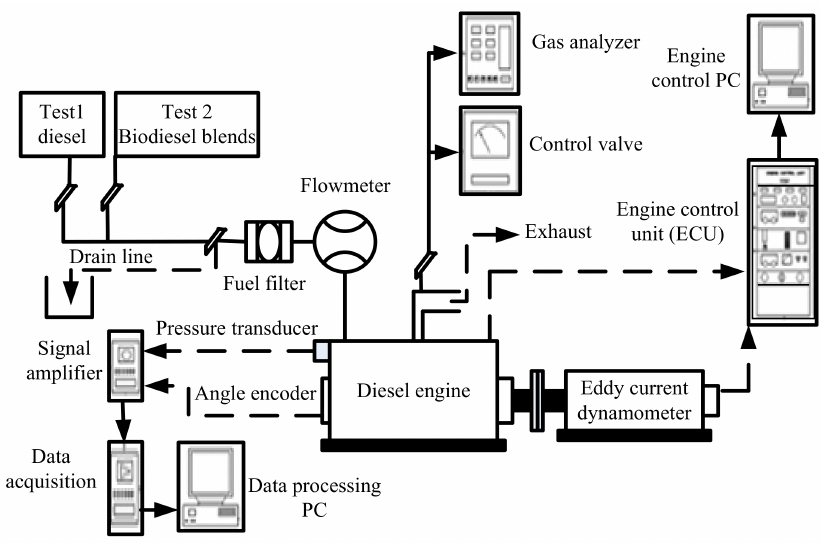
Figure 1. Schematic diagram of engine testing. Table 3. Engine and dynamometer